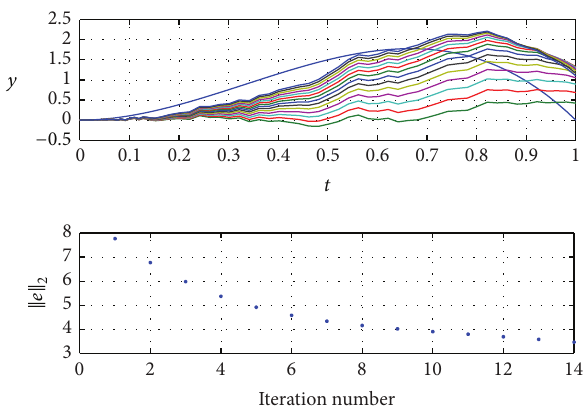
Figure 4: The simulation results of the ILC scheme (45) and (2).